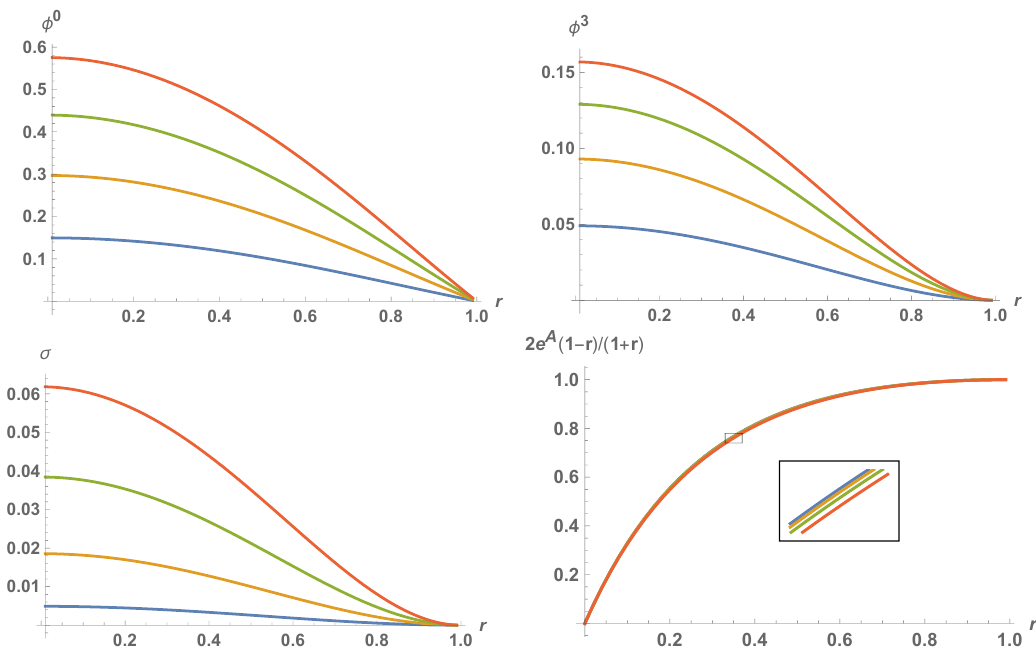
Figure 1 . Graphs of the BPS solutions based on our perturbative analysis. We choose (cid:15) = 0 : 4 ; 0 : 8 ; 1 : 2 ; 1 : 6, and lower (higher) curves for (cid:30) 0 ; (cid:30) 3 ; (cid:27) correspond to smaller (larger) values of (cid:15) . which in fact agrees with the series expansion of (cid:0) 4 (cid:11) into